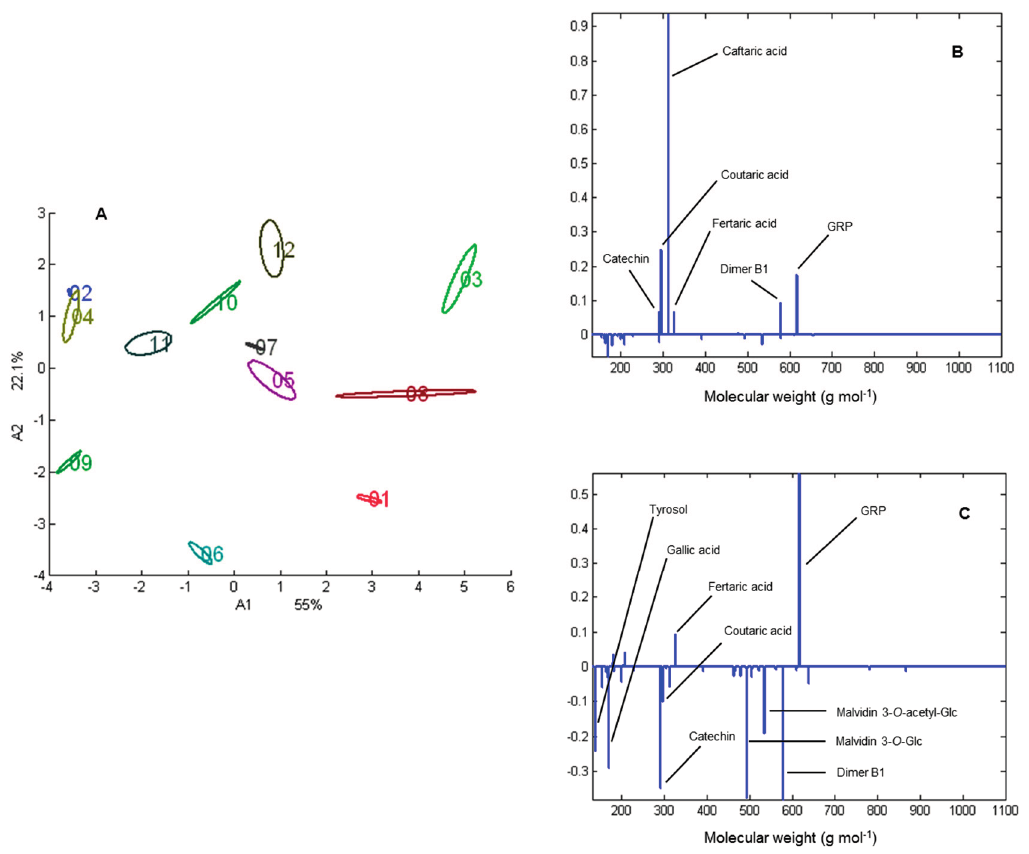
Figure 2. ( A ) PCA scores plot of the wines 1 to 12; ( B ) Loadings associated to the first common component A1; ( C ) Loadings associated to the second common component